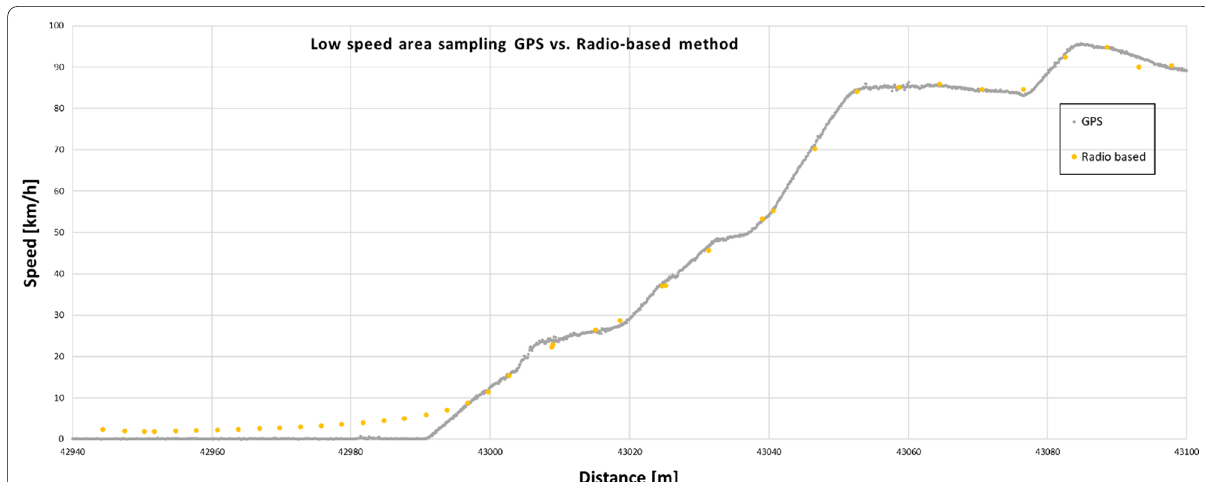
Fig. 8 Speed samples in the low-speed area with GPS measurement as reference